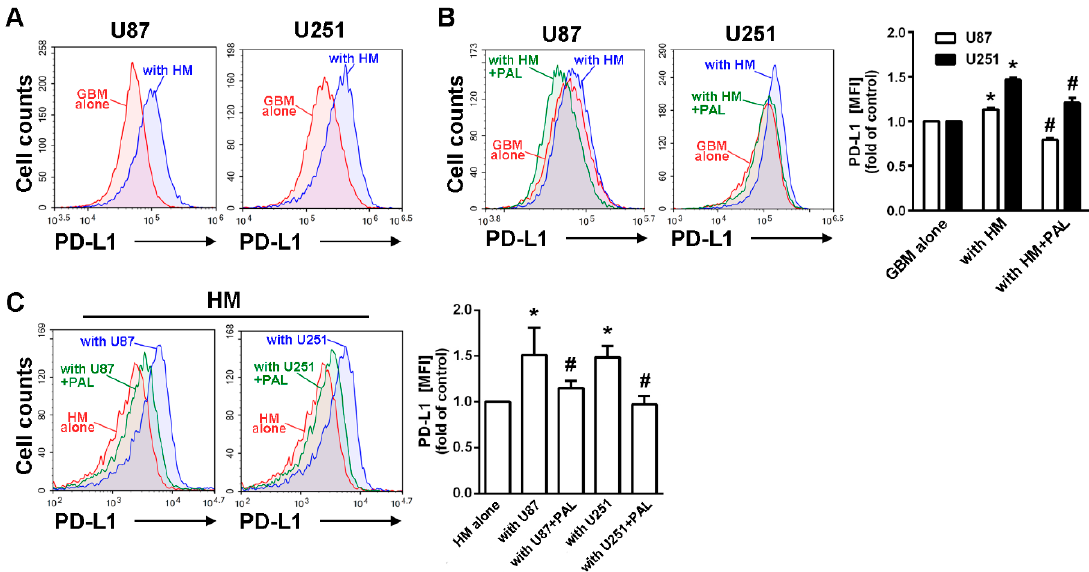
Figure 2. DRD2 involved in the PD-L1 expression in GBM cells in the GBM-macrophage co-culture system. ( A ) U87-GFP and U251-GFP cells were co-cultured with the THP-1 differentiated macrophage for 48 h. PD-L1 expression was determined by flow cytometry analysis. ( B ) U87-GFP and U251-GFP cells were treated with paliperidone (20 µ M, PAL) for 30 min, and cells were then co-cultured with THP-1 macrophages (HM) after wash-out of paliperidone for 48 h. PD-L1 expression on GBM was determined by flow cytometry analysis. * p < 0.05 compared with GBM alone group. # p < 0.05 compared with THP-1 group. ( C ) THP-1 macrophages (HM) were treated with paliperidone (20 µ M, PAL) for 30 min, washed out for 48 h, and then co-cultured with U87-GFP and U251-GFP cells. PD-L1 expression on cell surface of HM was determined by flow cytometry analysis. * p < 0.05 compared with THP-1 alone group. # p < 0.05 compared with U87 or U251 groups ( n = 3–4).